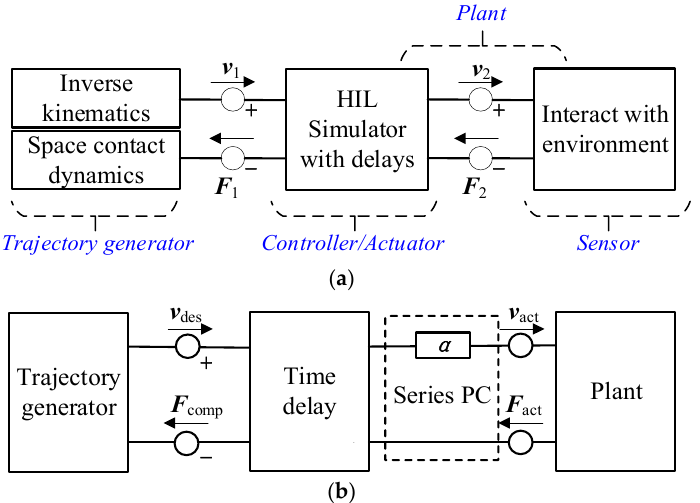
Figure 6. Passive network representing HIL simulation system. ( a ) Traditional control system view. ( b ) Network point of view.